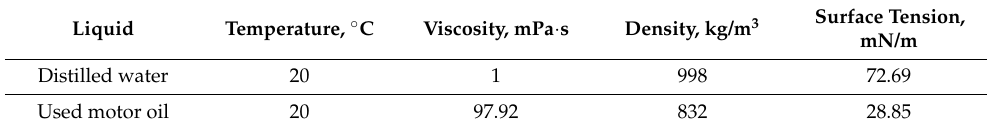
Table 1. Properties of liquids under study.